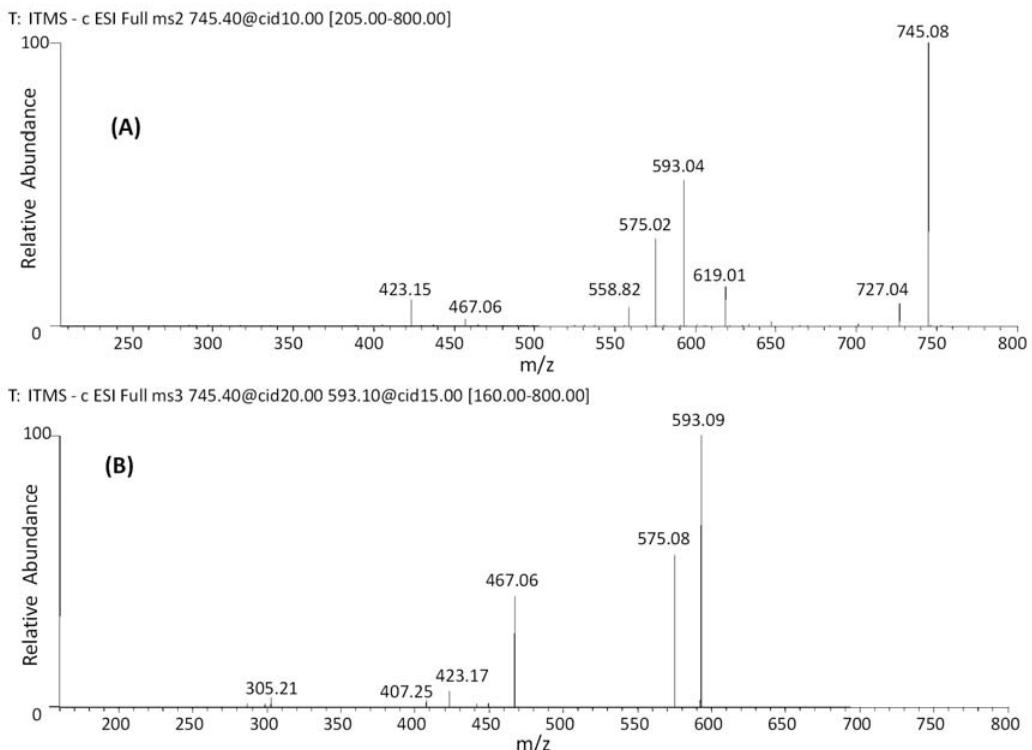
Figure 1. Negative ion ESI-MS n spectra of B-type dimer. ( A ) MS 2 of m/z 745 [M − H] − and ( B ) MS 3 of m/z 593 [M − H] −